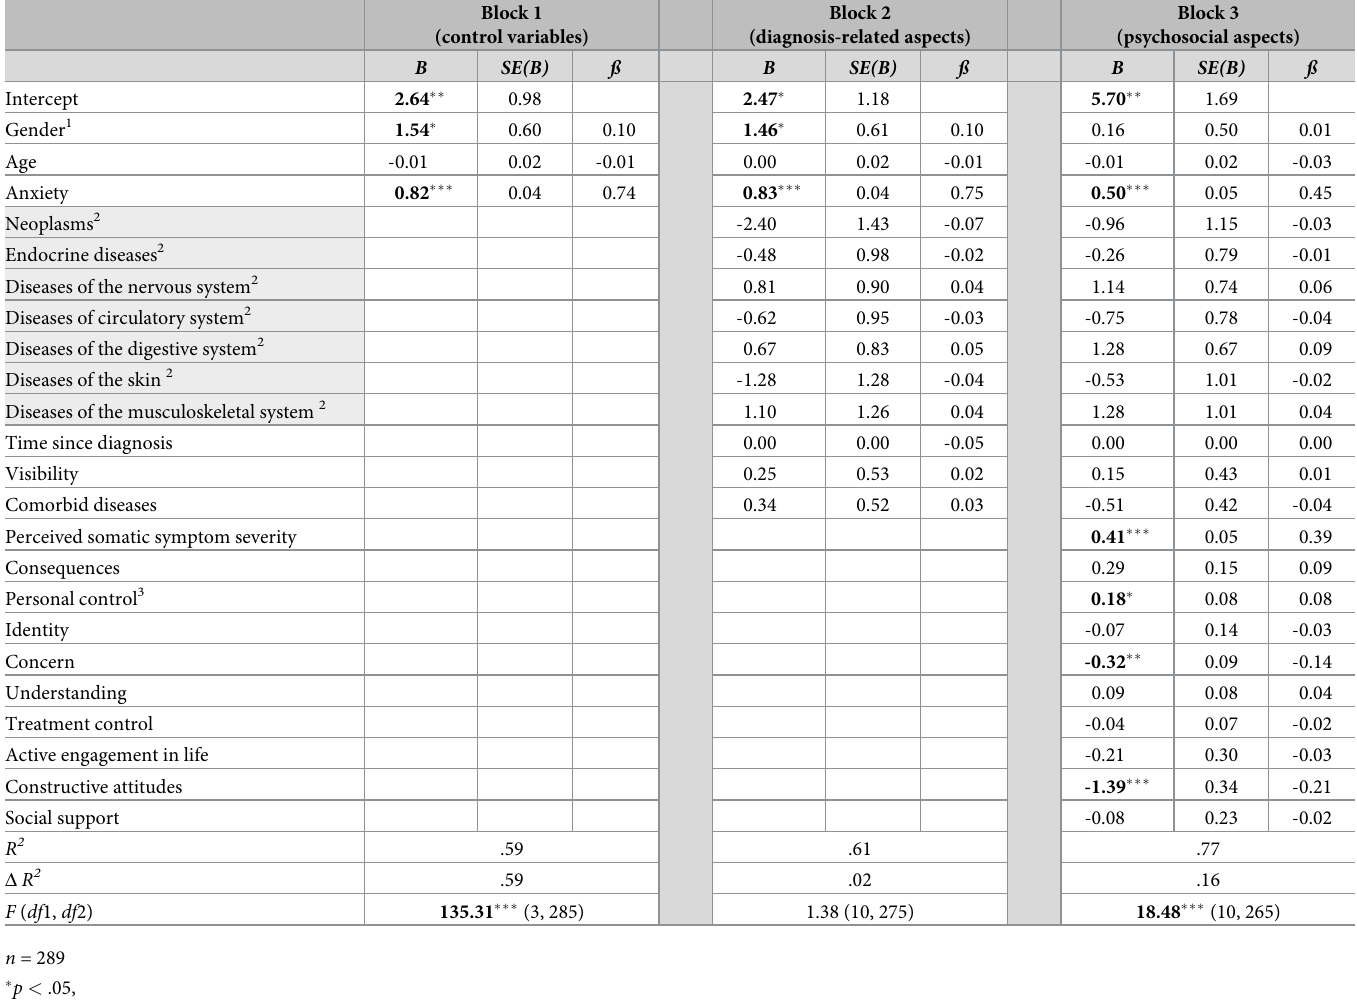
Table 2. Hierarchical linear regression model ( n = 289) with depression as dependent